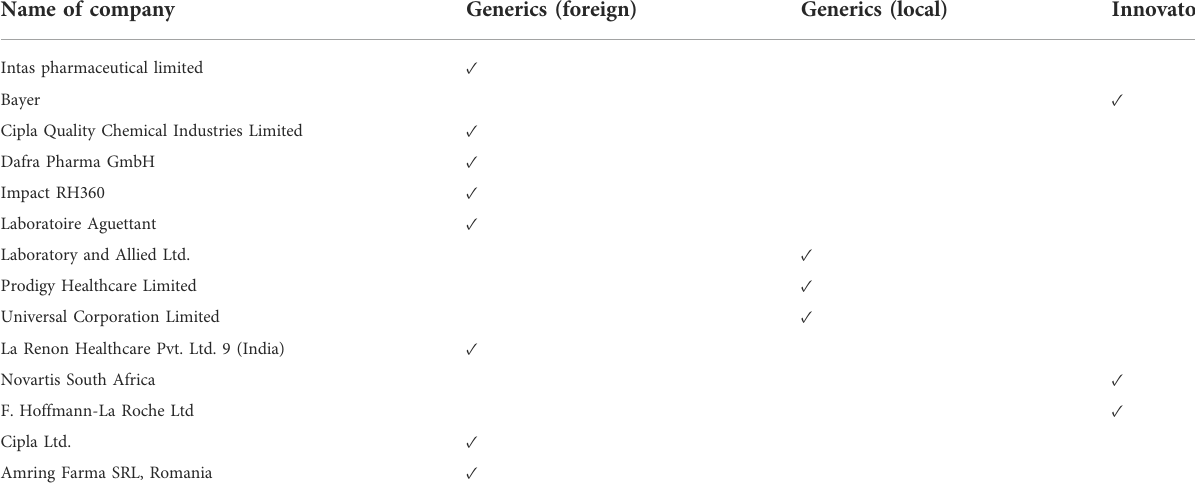
TABLE 1 Pharmaceutical companies participating in